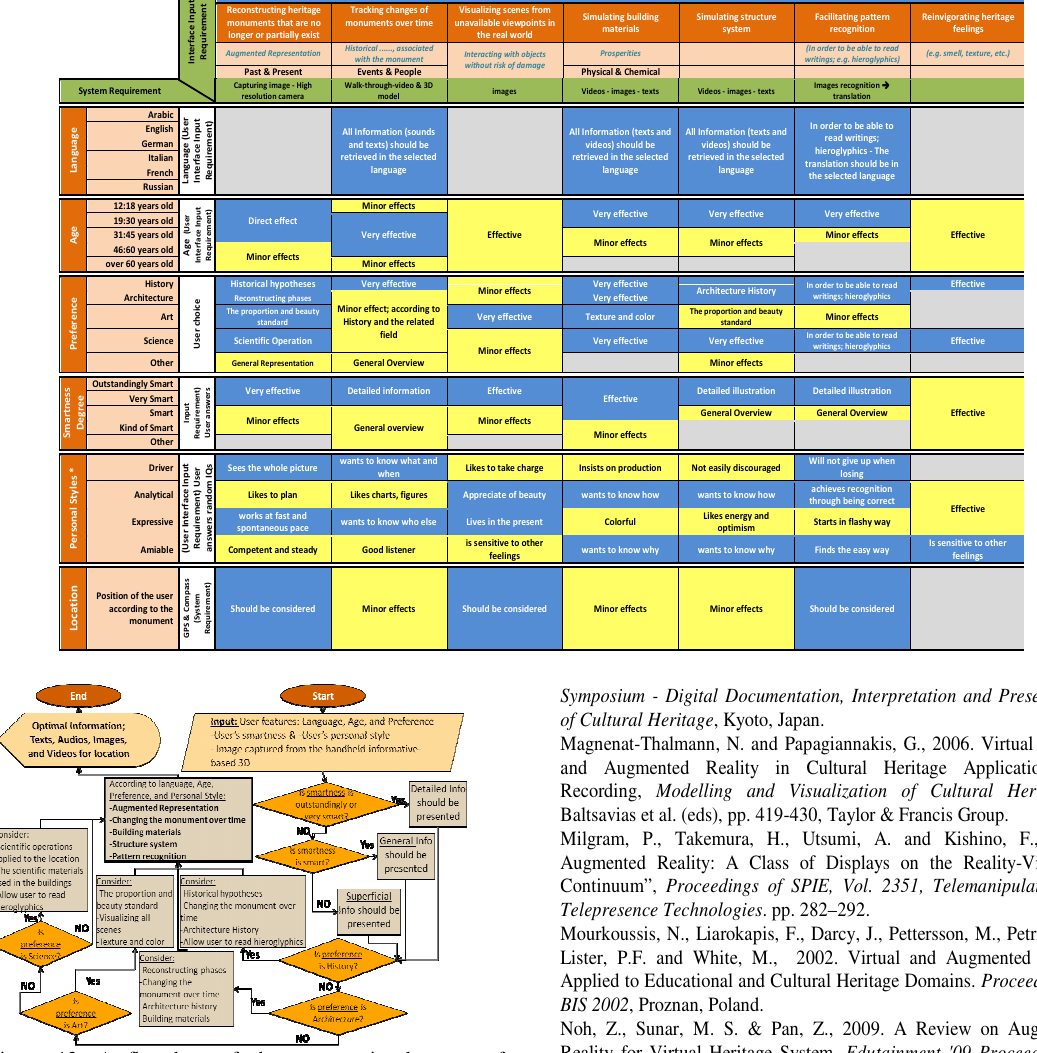
Figure 13. A flowchart of the computational system for obtaining the optimal information to users based on their interests and